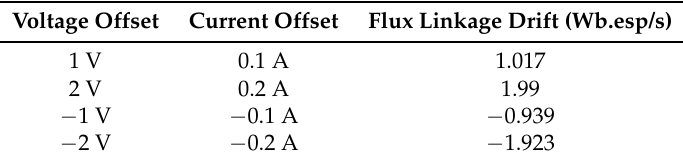
Table 1. Signal drift according to offset